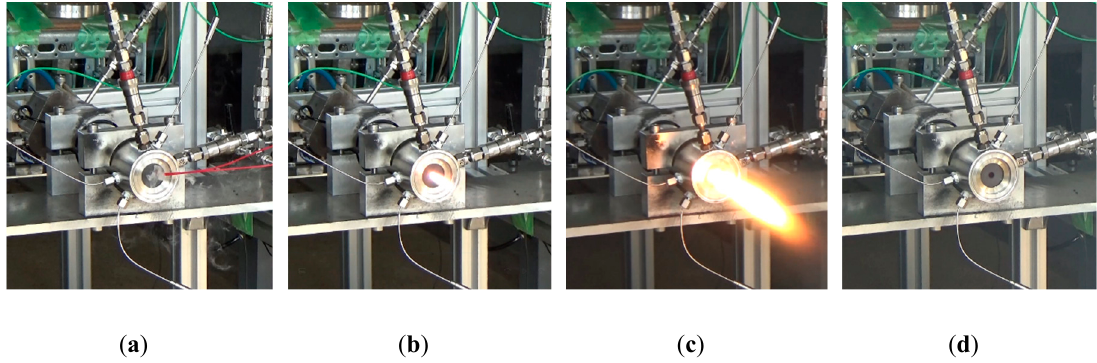
Figure 6. Screenshots of the firing test sequence ( a ) nichrome wire heating (0 s to 10 s); ( b ) O 2 ignition assist (10 s to 12 s); ( c ) main burn (12 s to 12 + t b s); ( d ) N 2 purge/cooling (12 s + t b s + 30 s).